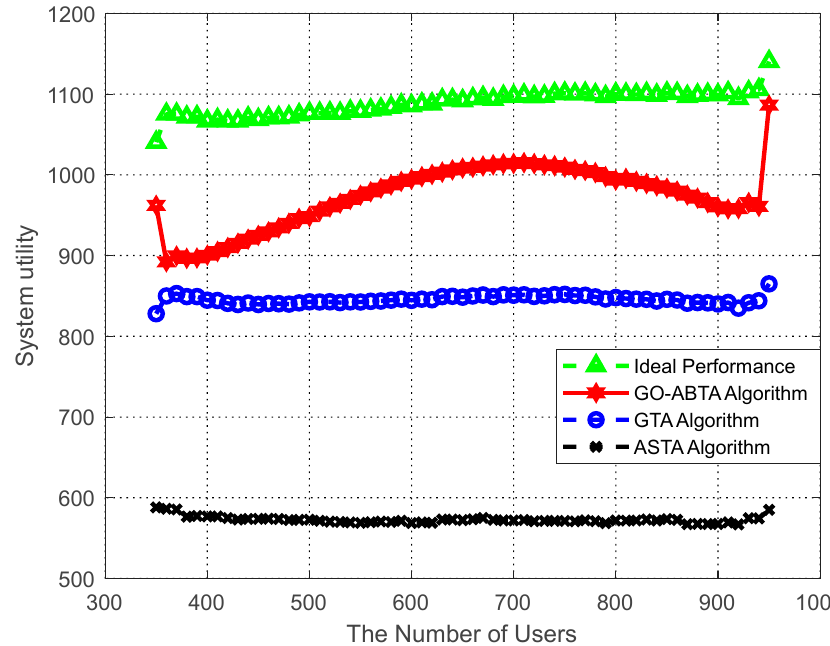
Figure 4. Performance of system utility compared to number of users.